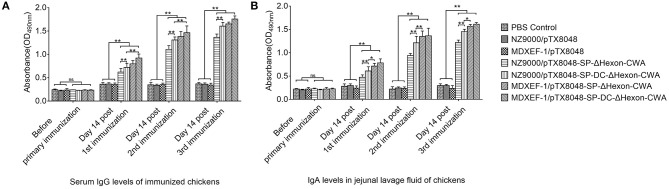
Detection of ΔHexon-specific IgG antibody levels in sera (A) and ΔHexon-specific sIgA antibody levels in jejunal lavage fluid (B) from chickens immunized with ΔHexon-expressing bacteria in each group. Recombinant ΔHexon protein in E. coli BL21 (10 μg/mL) was coated (100 μL per well). On day 14 post each immunization, ELISA method was used to determine the IgG levels in sera (A) and sIgA levels in jejunal lavage fluid (B). The values represent mean ± SD (n = 5). *p < 0.05, **p < 0.01.